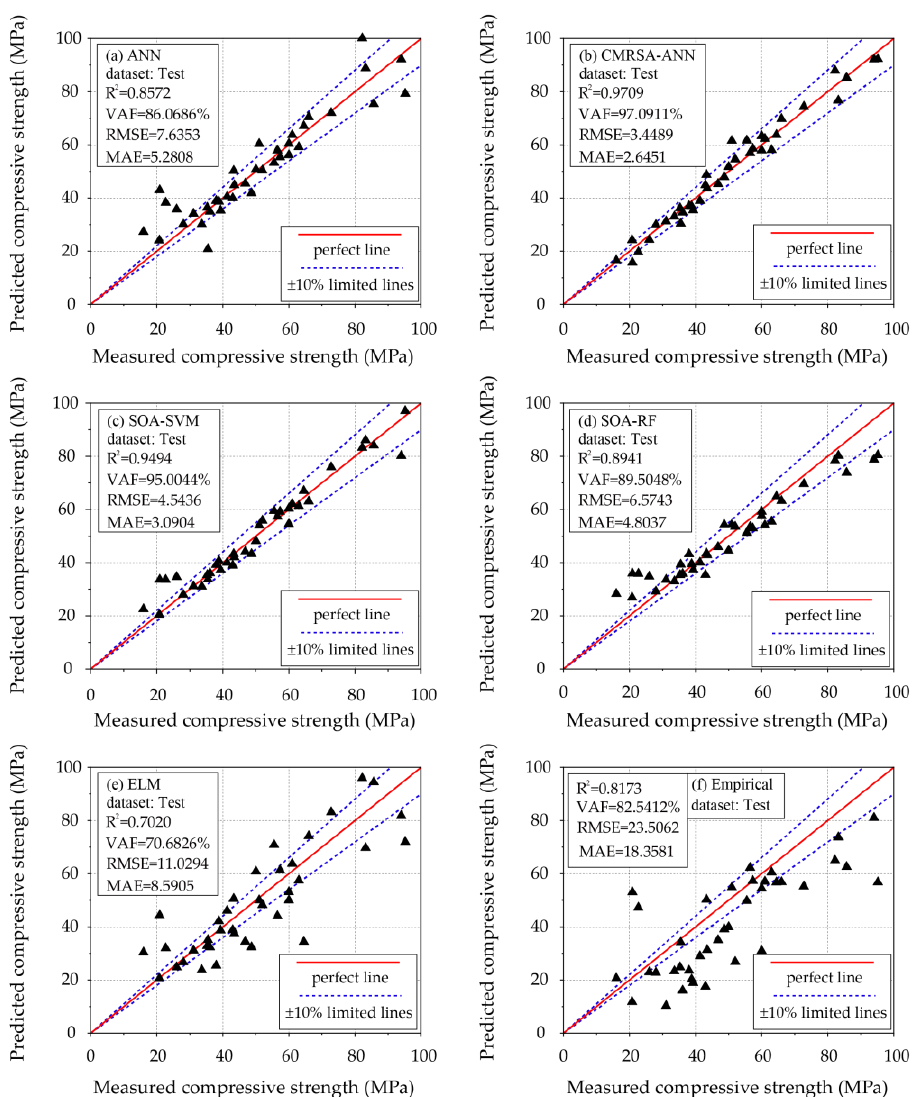
Figure 8. Regression results of all developed models using the test set.